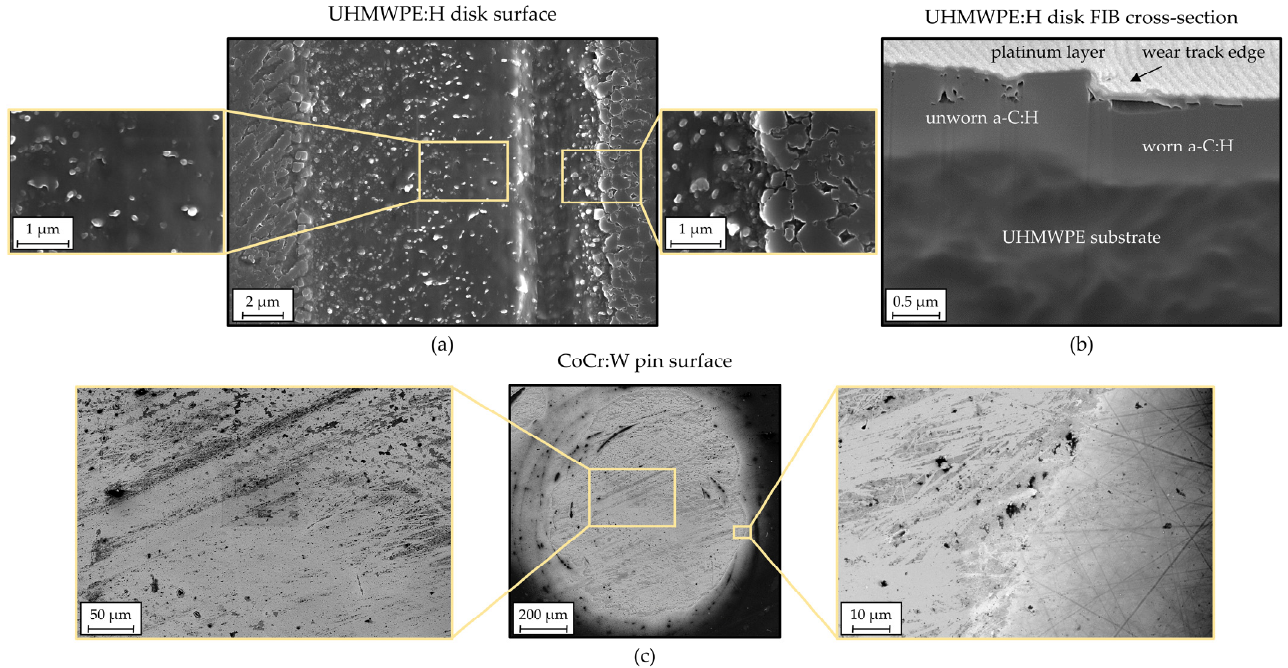
Figure 13. SEM micrographs of the wear track ( a ) and a FIB cross-section at the wear track edge ( b ) of the UHMWPE:H disk and SEM micrographs of the worn CoCr:W pin surface ( c ).